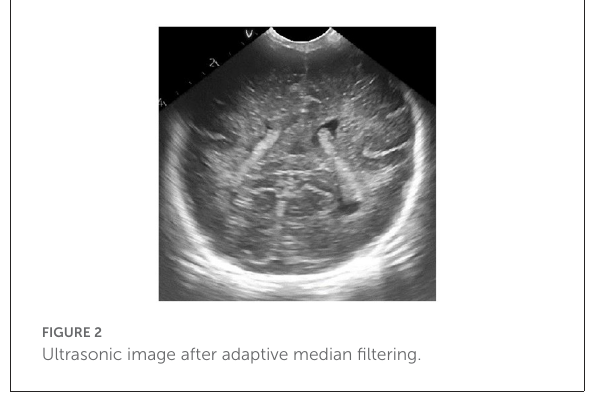
FIGURE2 Ultrasonic image after adaptive median filtering.